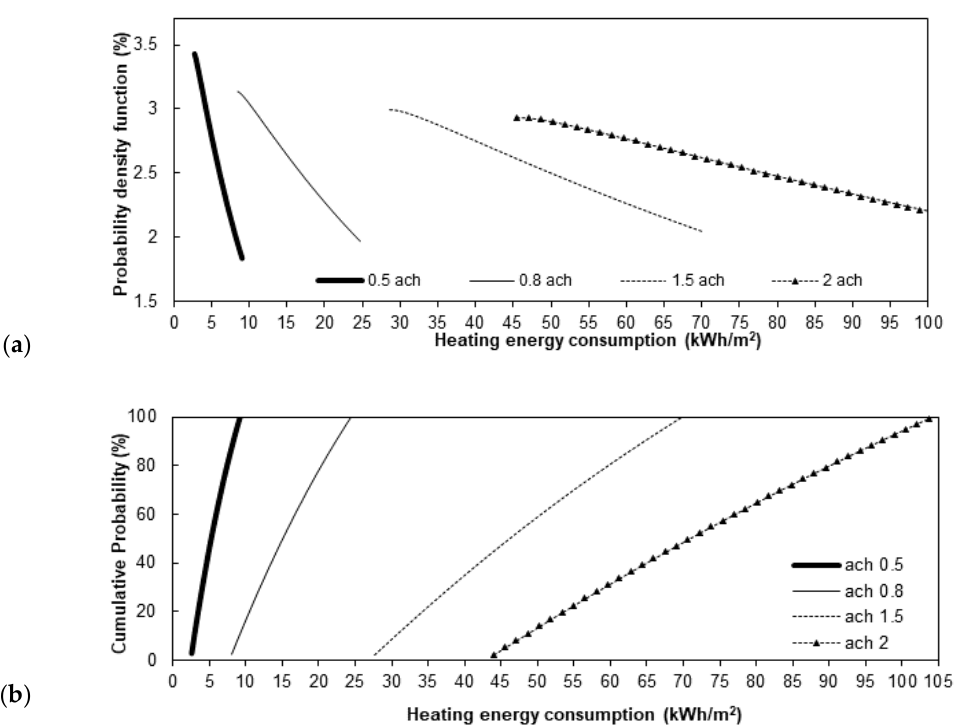
Figure 3. Probability density functions ( a ) and cumulative probability ( b ) of the heating energy consumption for different air changes (Ach = 0.5, Ach = 0.8, Ach = 1.0, Ach = 2.0).